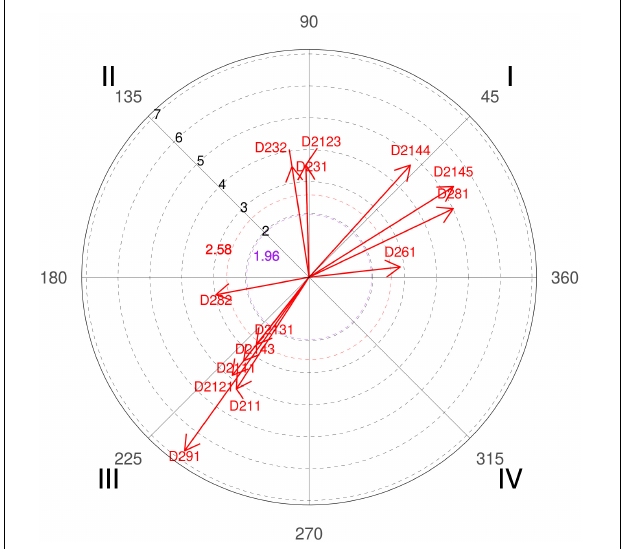
FIGURE 10 | Relationship of conditioned behaviors that present a significant relationship with the focal behavior “favorable evaluation” analyzing question 15 of the in-depth interviews. In “favorable evaluation,” a total of 14 significant vectors were detected.